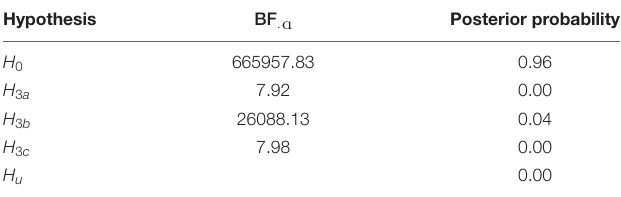
TABLE 3 | Bayesian informative hypothesis testing (ANOVA) of Trust.